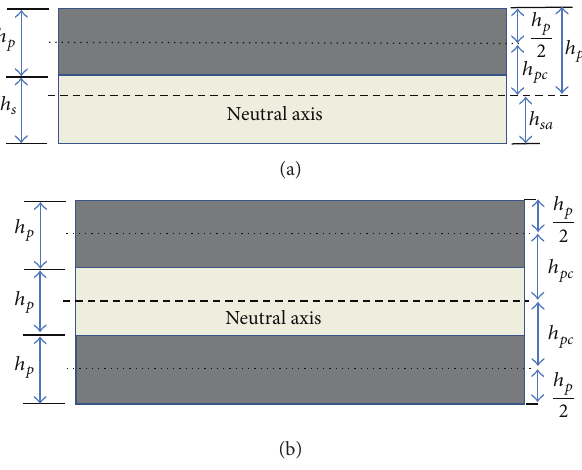
Figure 2: Piezoelectric beam cross section: (a) one-layered piezo- electric beam and (b) two-layered piezoelectric